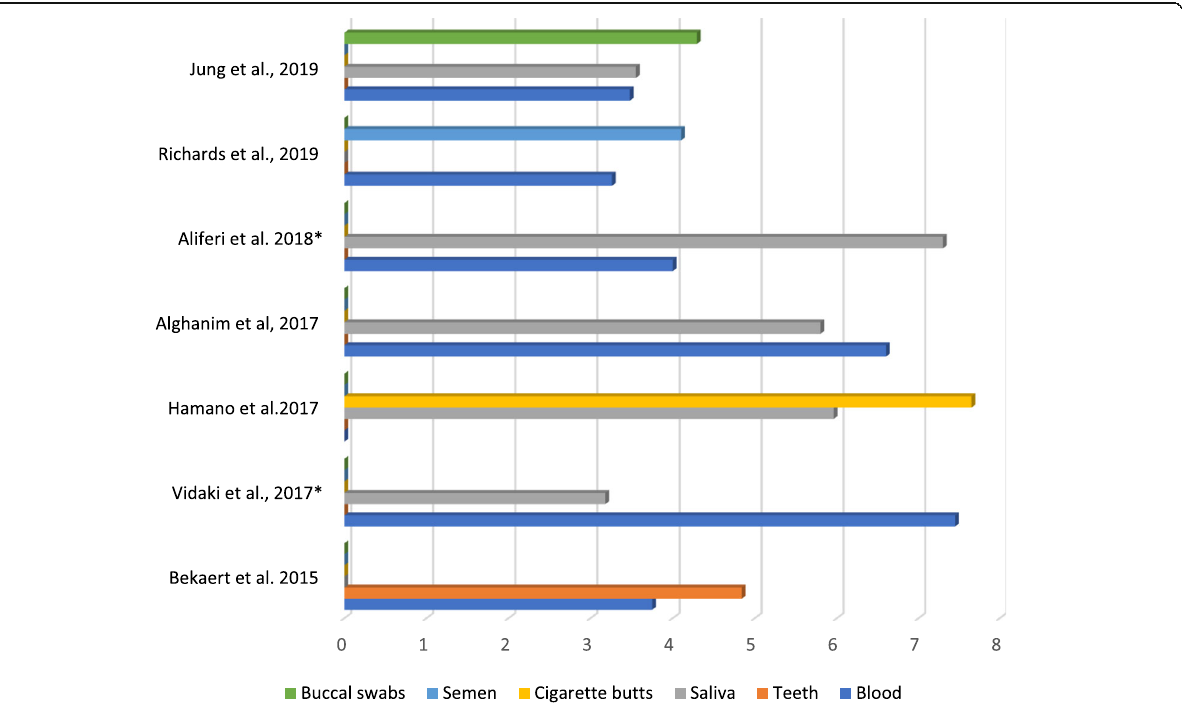
Fig. 10 The age prediction in mixed samples in MAD (years), *in MAE